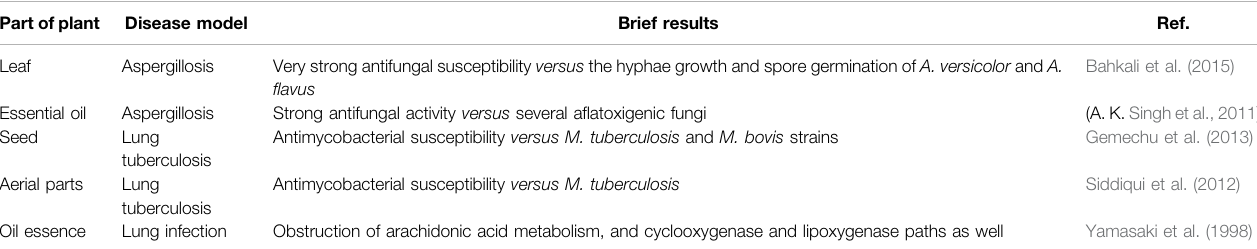
TABLE 3 | Summarized clinical effects of O. basilicum on respiratory diseases. Part of plant Disease model